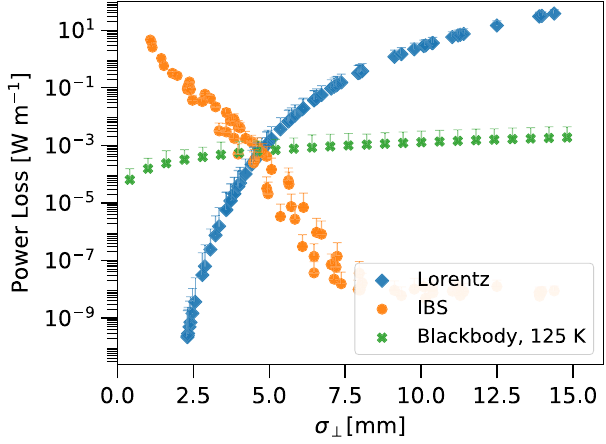
8. Dependence of blackbody, IBST, and Lorentz stripping (quadrupoles only) on average transverse beam size σ ⊥ for a 2.5 GeV beam traversing a FODO lattice ( 6 m × 20 cells) of one quadrupole pair and one bunching gap per cell. Beam parameters are determined by setting phase advance and solving for optimum inputs. A range of 1 – 90° phase advance runs gives the resulting range of beam sizes. Blackbody stripping is simulated separately, assuming a constant σ ⊥ for each point. axis and closer to the magnet pole tips encounter an increased gradient.